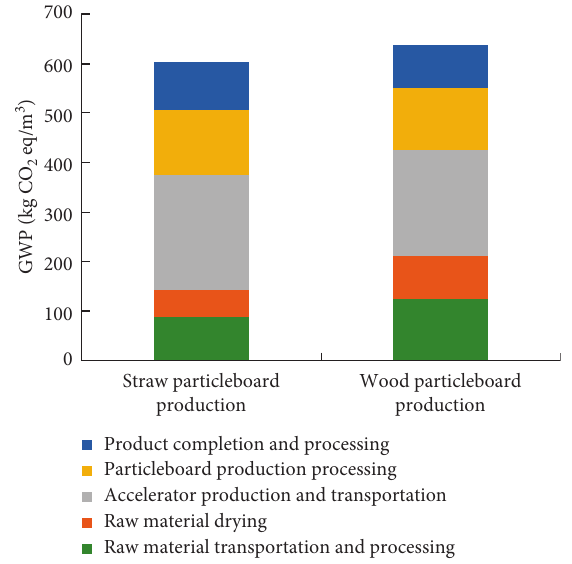
Figure 3: Contribution of particleboard production process to GWP